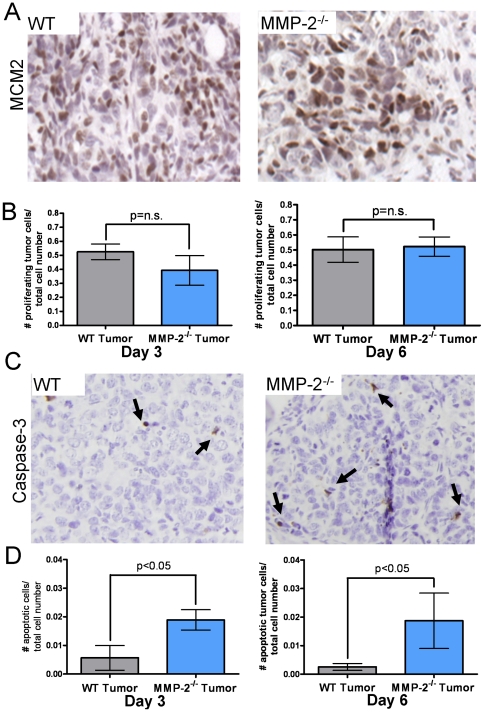
Host-derived MMP-2 impacts tumor survival in the bone microenvironment.
A, Representative photomicrograph of MCM2 positive proliferating (brown) cells in the wild type (WT) and MMP-2 null (MMP-2−/−) tumor-bone microenvironment. B, Proliferation in the tumor-bone microenvironment as a function of total cell number was assessed by staining for Mcm2 in tumor bearing tibias of WT and MMP-2 null mice at day 3 and day 6 post-surgery. C, Representative photomicrograph of caspase-3 positive apoptotic (brown) cells in the wild type (WT) and MMP-2 null (MMP-2−/−) tumor-bone microenvironment. D, Apoptosis in the tumor-bone microenvironment as a function of total cell number was assessed by staining for cleaved caspase-3 at day 3 and day 6 post surgery. Data are mean ± SD; n.s. implies a non-significant p value (p>0.05).